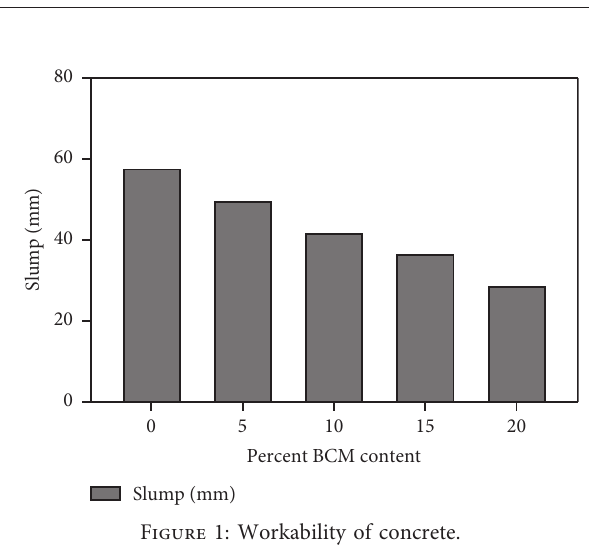
Figure 1: Workability of concrete.